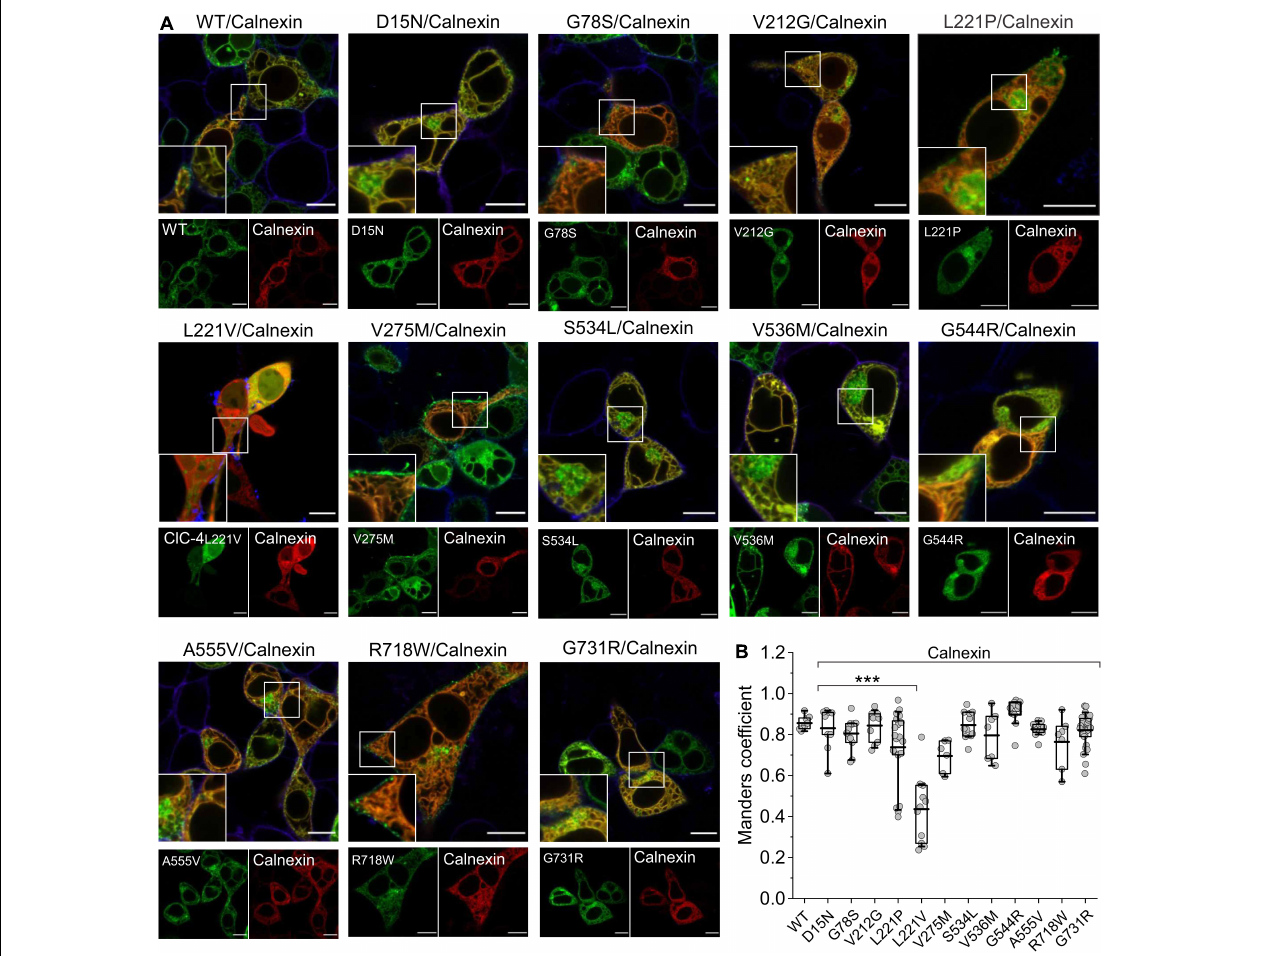
FIGURE 7 | Subcellular localization of WT and mutant ClC-4 homodimers. (A) Representative confocal images of HEK293T cells co-expressing WT or mutant ClC-4 together with the endoplasmic reticulum marker calnexin. Note that all mutants localize to the ER; however, the V275M and R718W variants are also present within the plasma membrane, and D15N, V536M, A555V, and S534L also localize to perinuclear structures. Inset shows areas outlined in the white boxes. (B) Mean values for Mander’s overlapping coefficients (WT, n = 8; D15N, n = 9; G78S, n = 11; V212G, n = 10; L221P, n = 20; L221V, n = 11; V275M, n = 6; S534L, n = 11; V536M, n = 7; G544R, n = 11; A555V, n = 11; R718W, n = 7; G731R, n = 27). *** p < 0.001. ClC-4 mutants plus calnexin were compared with WT ClC-4 plus calnexin using one-way analysis of variance (with Tukey’s HSD post hoc testing). Data were obtained from three or four independent transfections and are presented as boxplot boxes indicating upper and lower quartiles; whiskers indicate upper and lower 90%. Scale bar represents 10 µ